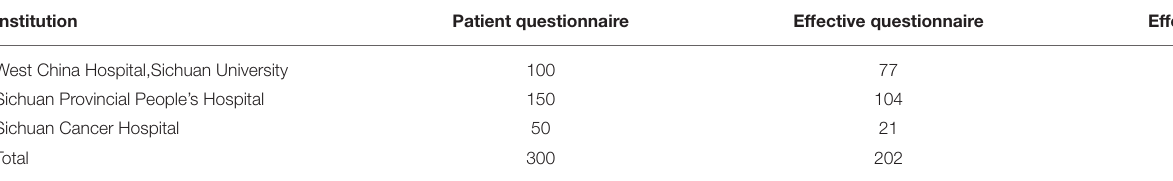
TABLE 2 | Patients’ preferences study on treatment of non-small cell lung cancer–collection of the questionnaires.